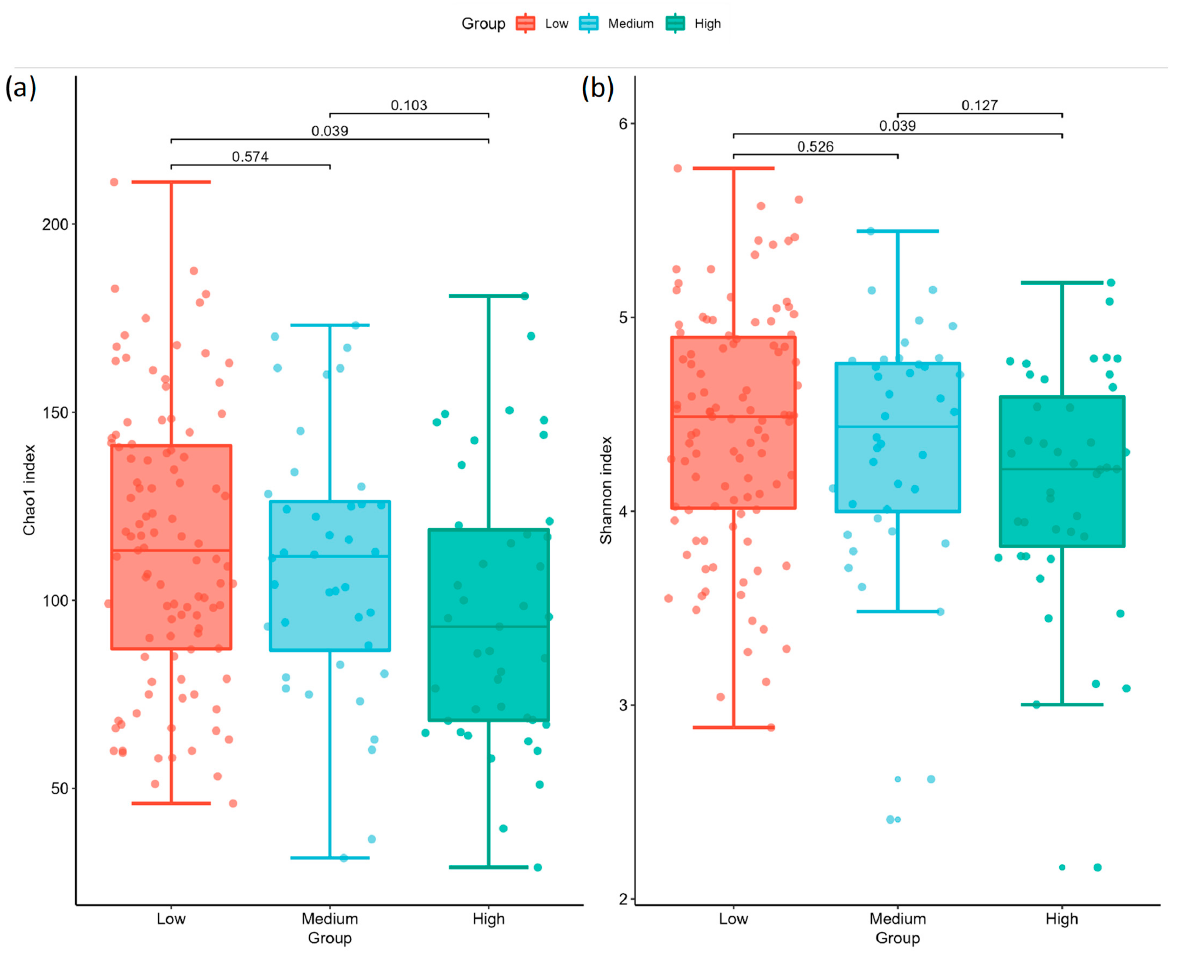
Figure 1. Comparisons of alpha diversity indices for (a) Chao1 and (b) Shannon across AoAc levels. Each dot represents a diversity index of one sample. The center lines in boxes represent the medians; box limits indicate the 25th and 75th percentiles; whiskers extend 1.5 times the interquartile range from the 25th and 75th percentiles. The p values for pairwise comparisons are shown on each pair of brackets.